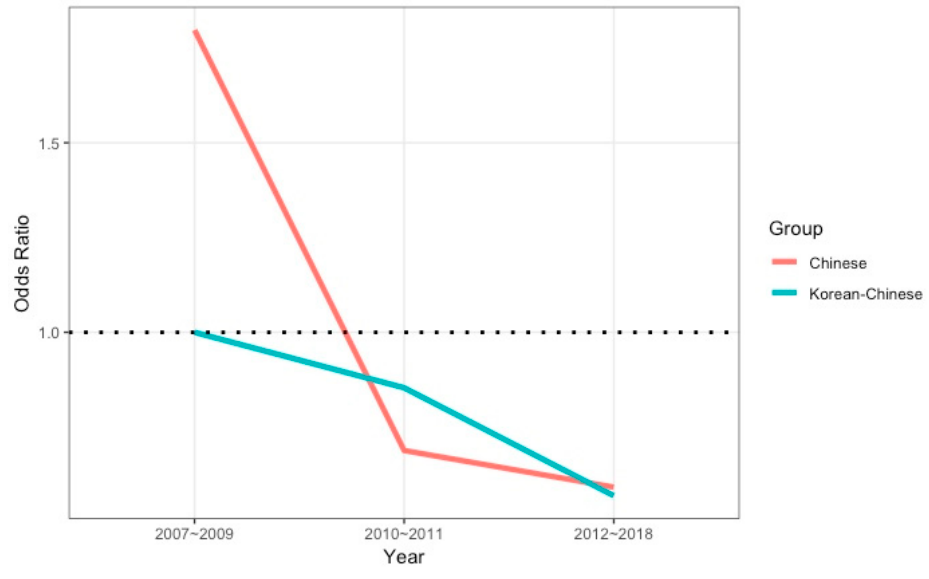
Figure 2. Group and year interaction odds ratio plot.